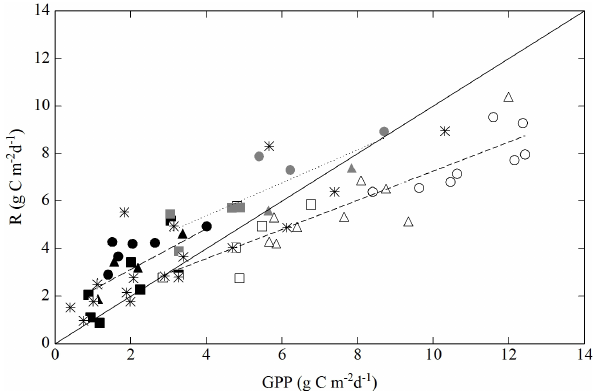
Fig. 4. Relationship of daily integrated average gross primary pro- ductivity (GPP) and ecosystem respiration (R) at all sites for unman- aged and mowing and grazing periods from 2002 to 2008, as based on the approach for Fig. 3. Sites and management periods are indi- cated by symbols: circles (valley bottom meadow), triangles (moun- tain meadow), quadrats (pastures) and stars (abandoned); open sym- bols (unmanaged periods, spring and summer), closed symbols (un- managed periods, autumn) and grey symbols (mowing and grazing periods, summer). The solid line is the 1:1 line, the dotted regres- sion lines indicate linear relationships, as described by R = a × GPP + b. a, b and R 2 of the linear regressions are as follows: 0.61, 1.13 and 0.80 for unmanaged periods in spring and summer, 0.86, 1.41 and 0.44 for unmanaged periods in autumn, and 0.69, 2.60, 0.71, respectively, for mowing and grazing periods (during